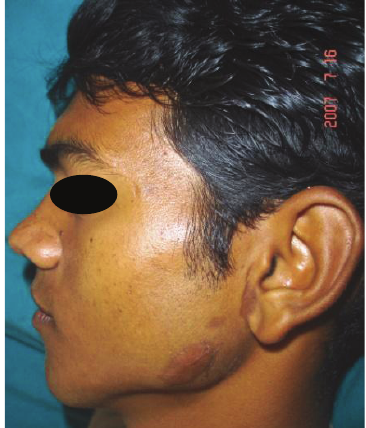
Figure 3: Pre-op left lateral view.